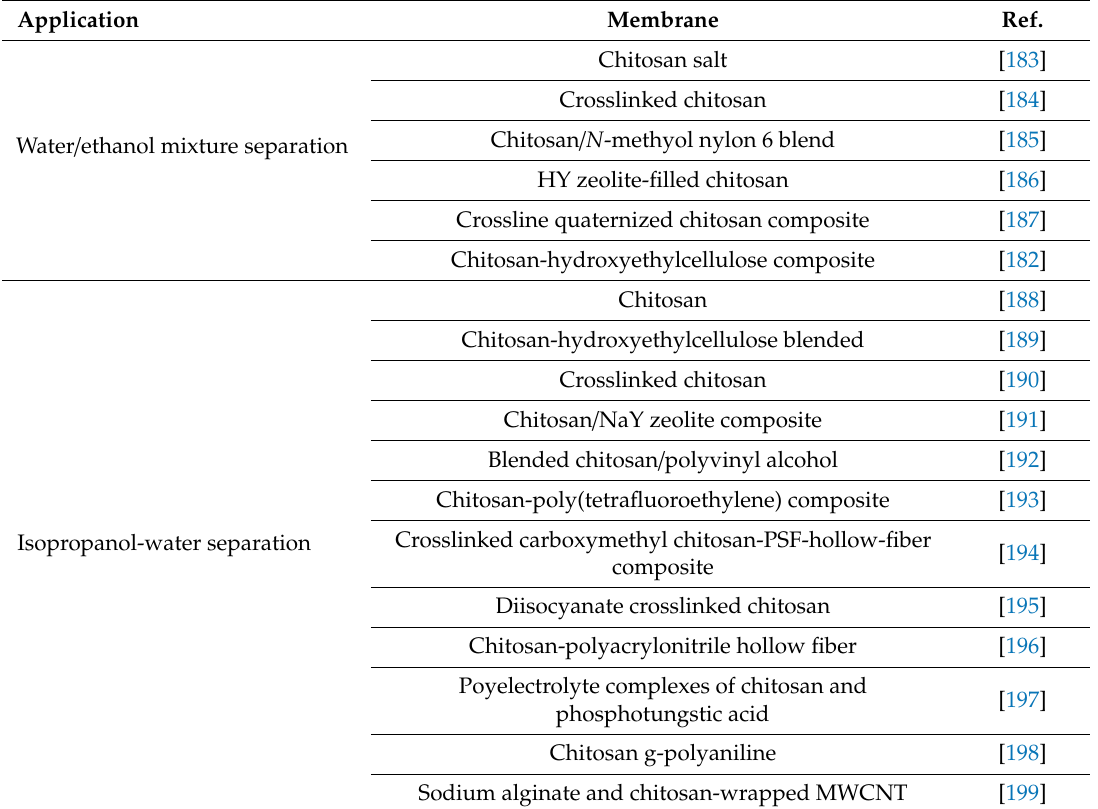
Table 11. Chitosan-based composites and its uses in separation processes.